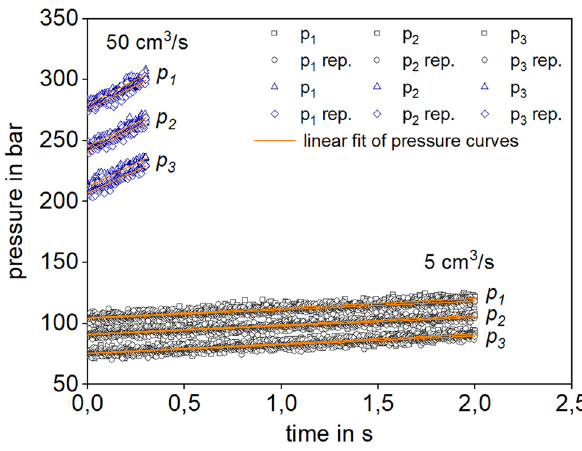
Figure 4: Reproducibility of pressure acquisition within the relevant fi lling phase for PS at 280°C and 0.5 wt% N